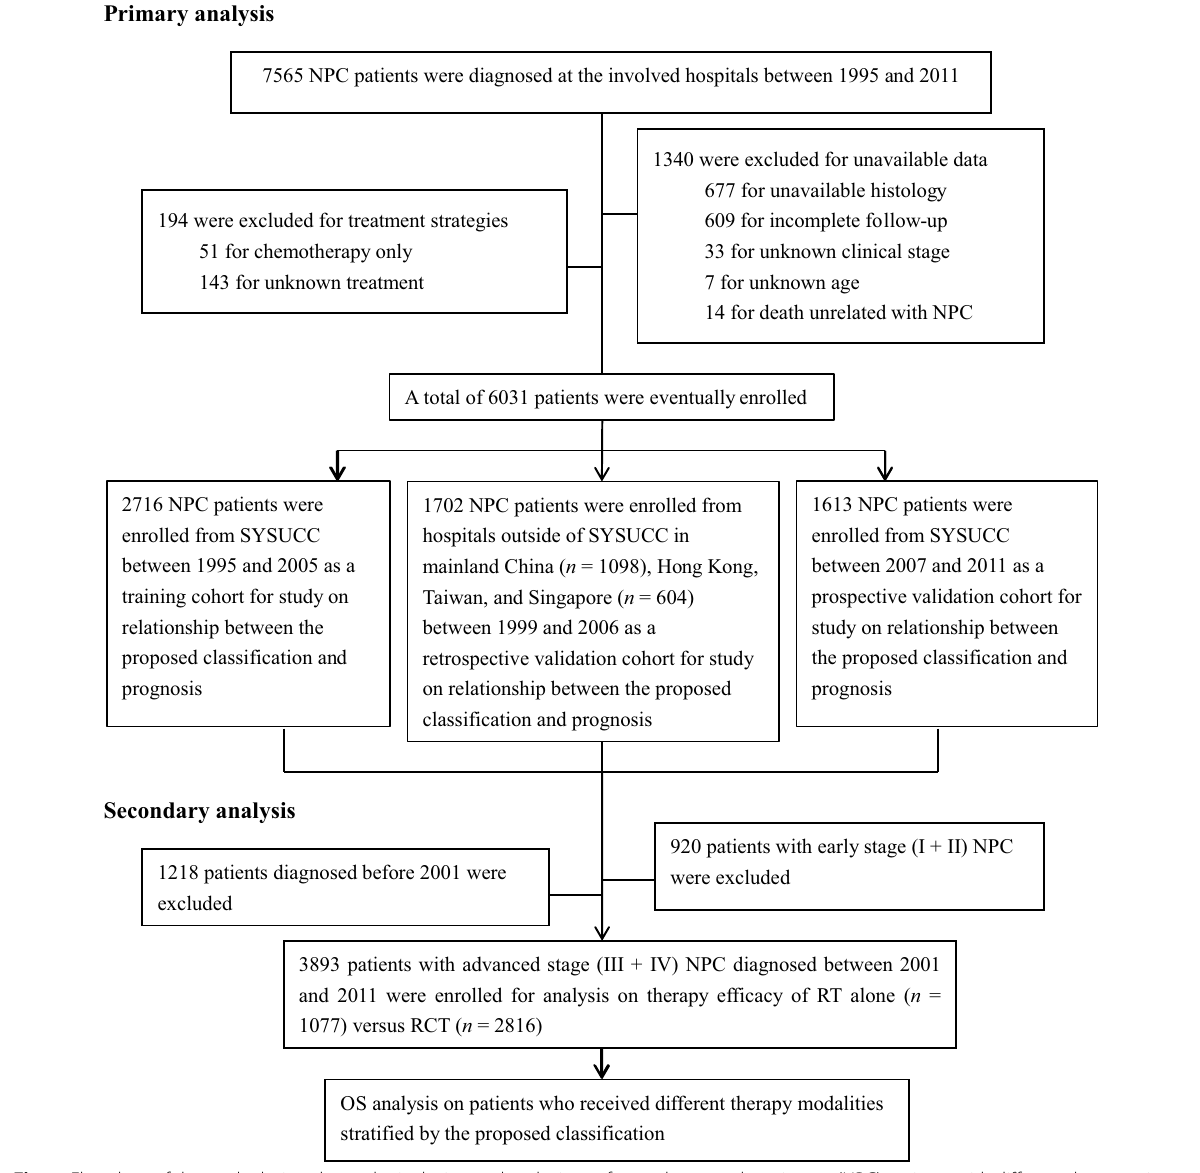
Fig. 1 Flowchart of the study design shows the inclusion and exclusions of nasopharyngeal carcinoma (NPC) patients with different